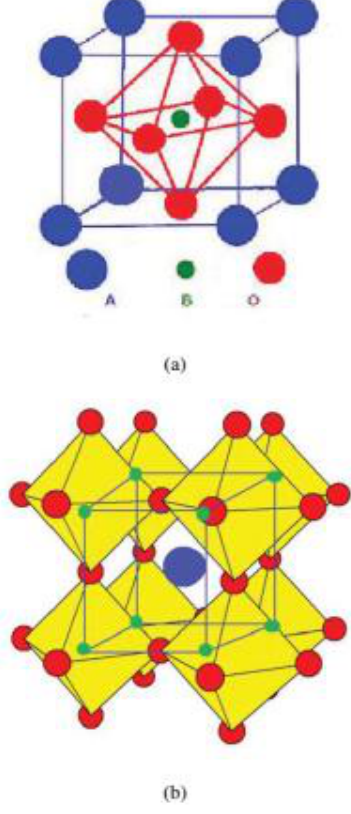
Figure 1. ( a ) ABO 3 ideal cubic perovskite structure and ( b ) the perovskite framework Mishra, A.; Prasad, R. Preparation and application of perovskite catalyst for diesel soot emission control: